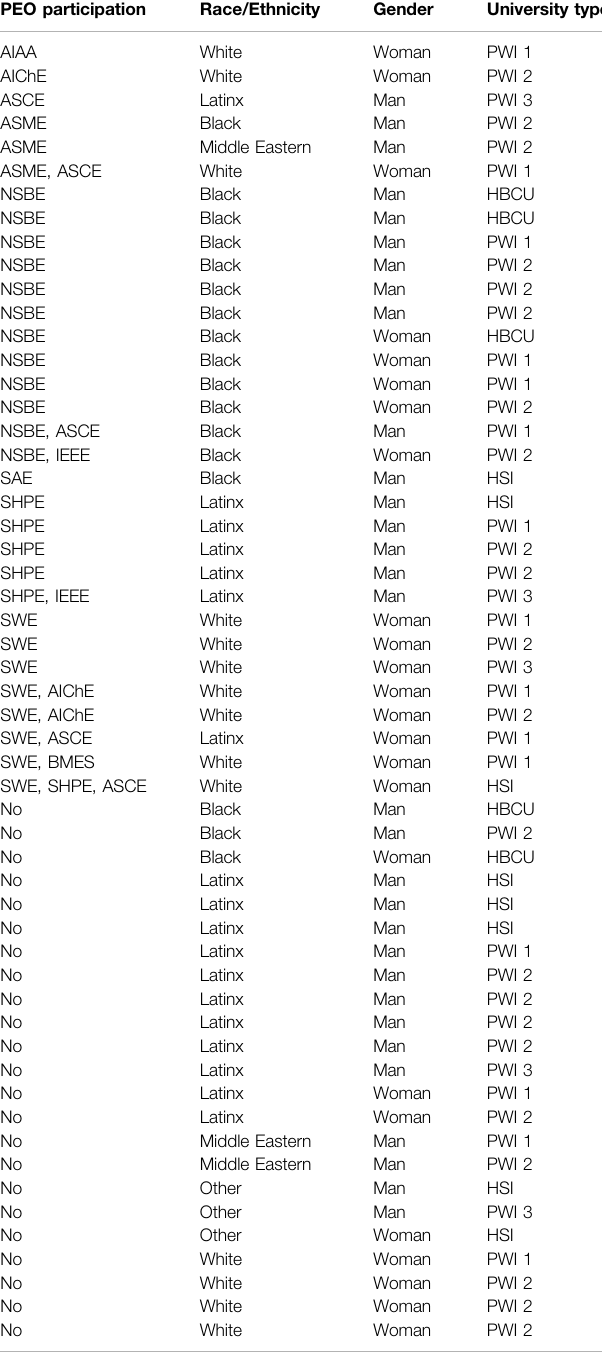
TABLE 1 | PEO participation and participant characteristics of interviewees ( n (cid:1) 55). PEO participation